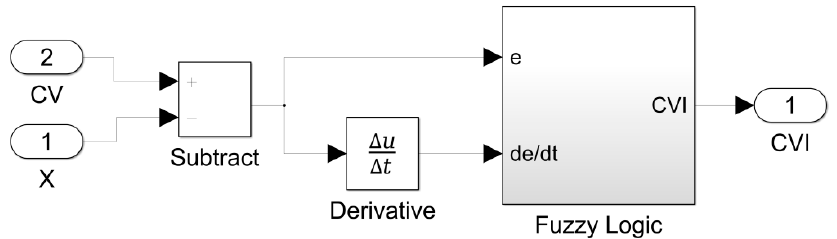
Figure 9. The simplified block schematics of the Simulink model of the fuzzy PD controller.